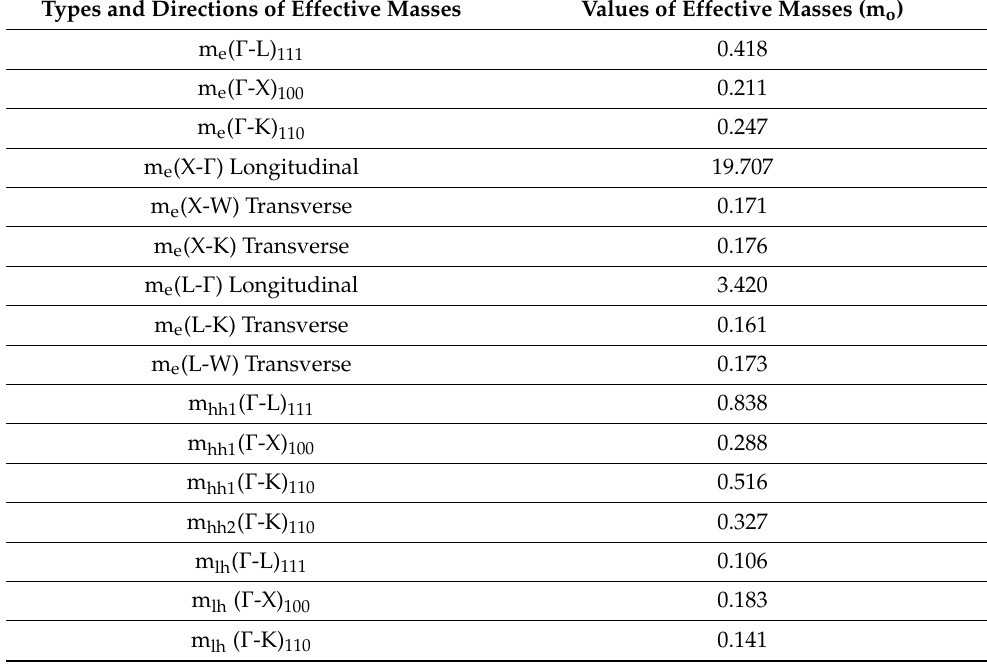
Table 5. Calculated effective masses for antifluorite Mg 2 Si in units of free electron mass (m o ). m e indicates an electron effective mass at the X, Γ and, L points; m hh and m lh represent the heavy and light hole effective masses,